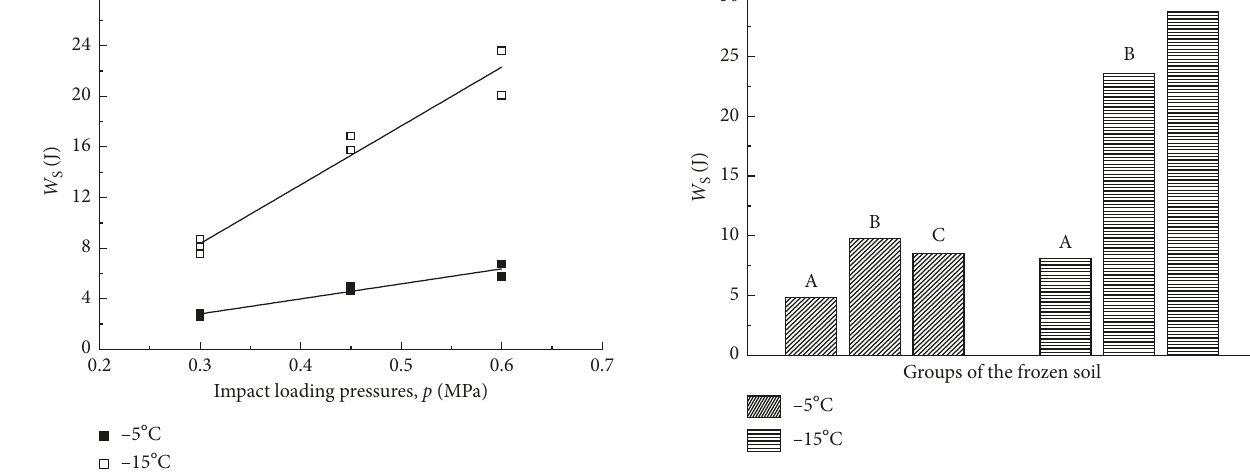
Figure 7: Comparison of average absorbed energy for three groups.